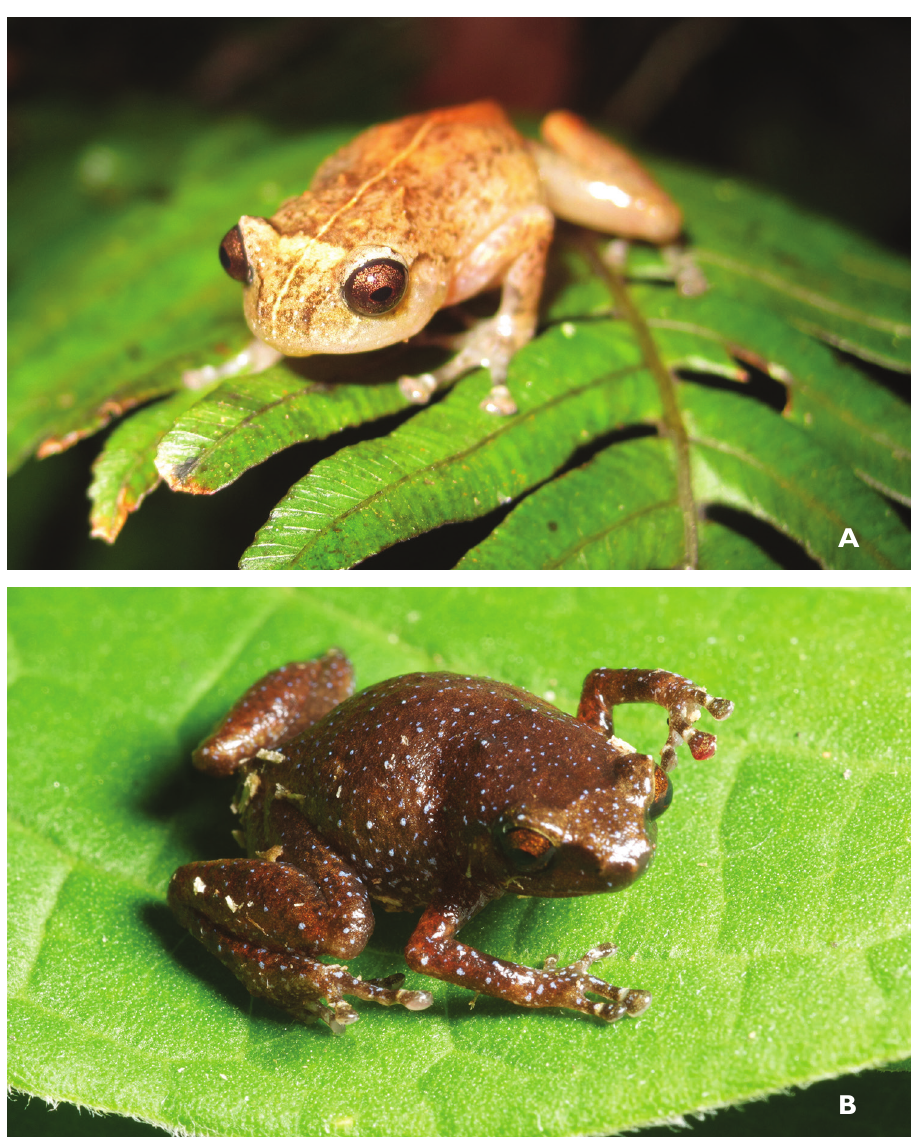
Figure 24. Oreophryne cf. nana male ( A KU 334100) from 1700 masl, Mt. Lumot, Municipality of Gingoog City, Misamis Oriental Province. (Photo: KAC) and from ( B KU 333330), male from Barangay Civoleg, Haribon Site, 1700 m, Mt. Lumot, Municipality of Gingoog City, Misamis Oriental Province. Photo: RMB